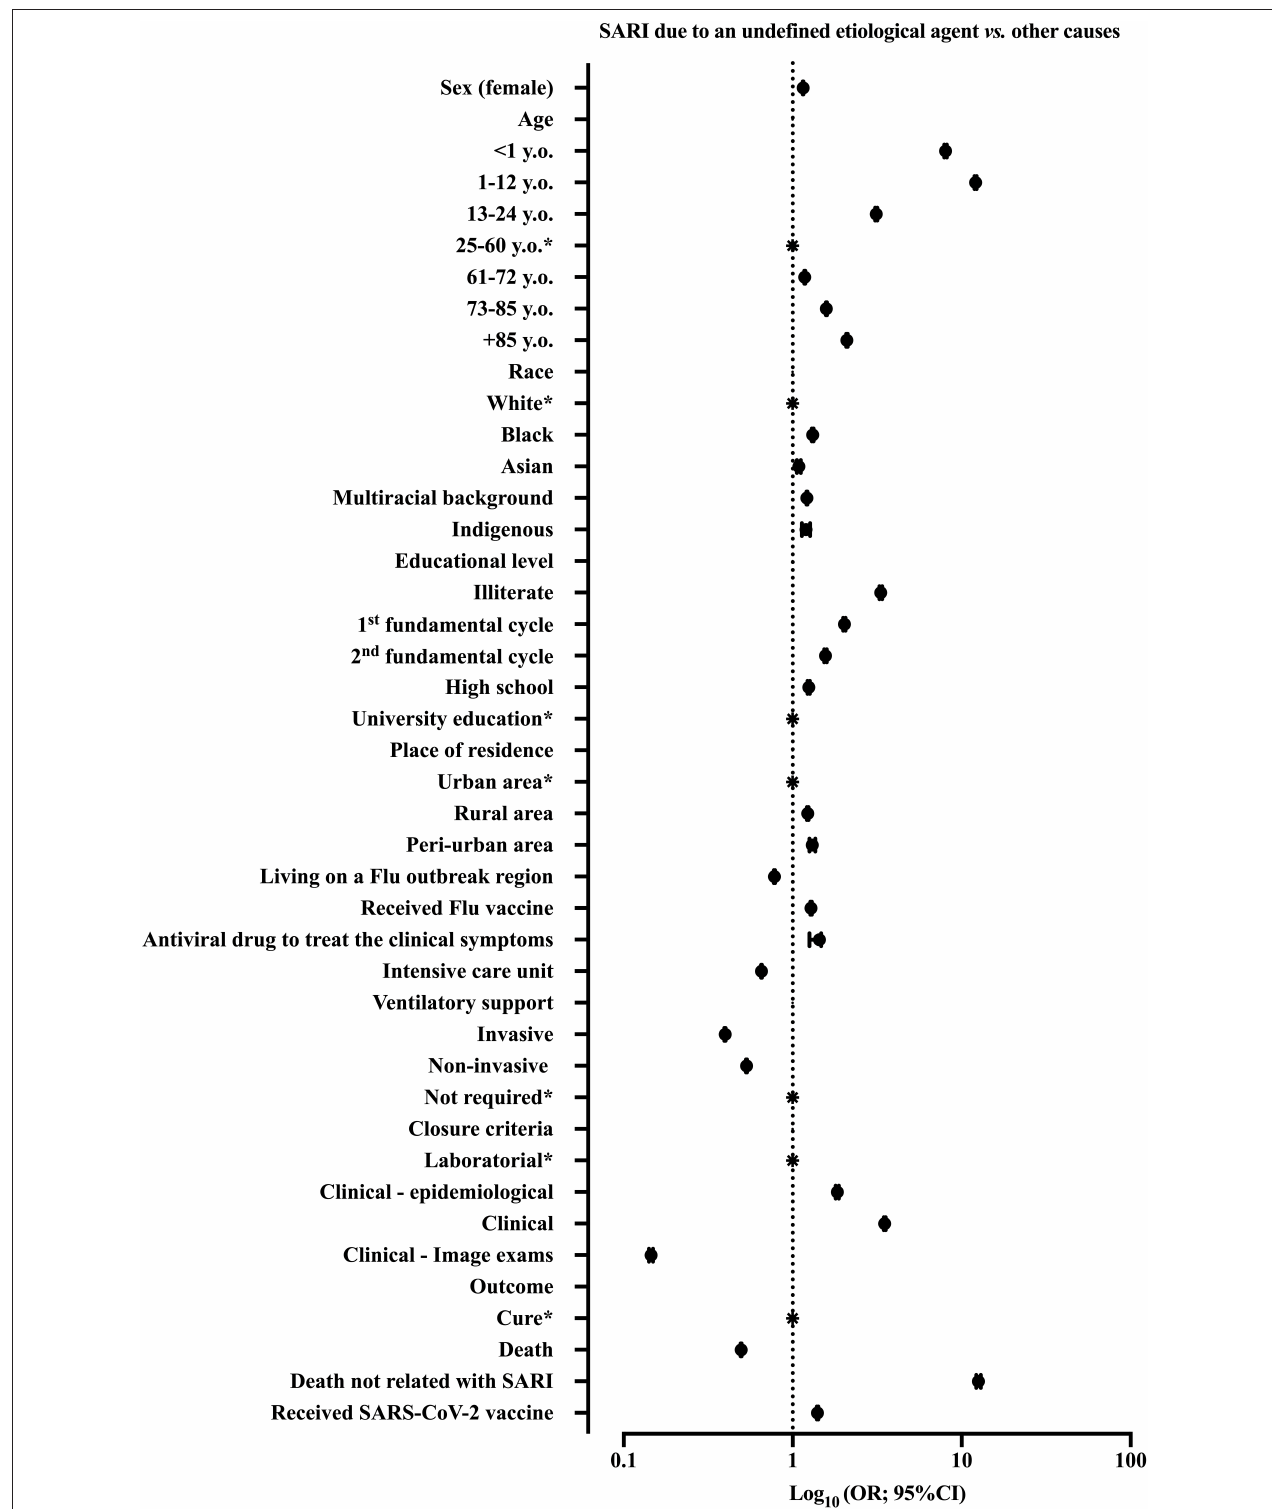
FIGURE 3 | We demonstrated the result of bivariate analysis to identify the patients’ features associated with severe acute respiratory infection (SARI) diagnosis. We compared the patients with SARI due to an undefined etiological agent vs. other causes. The other causes included SARI due to Influenza virus infection, SARI due to other respiratory viruses’ infection, SARI due to other known etiological agents, and SARI due to SARS-CoV-2 infection (patients with COVID-19). We demonstrated the odds ratios (ORs) and 95% confidence interval (95%CI). SARS-CoV-2, Severe Acute Respiratory Syndrome Coronavirus 2; y.o., years old. *Reference group.